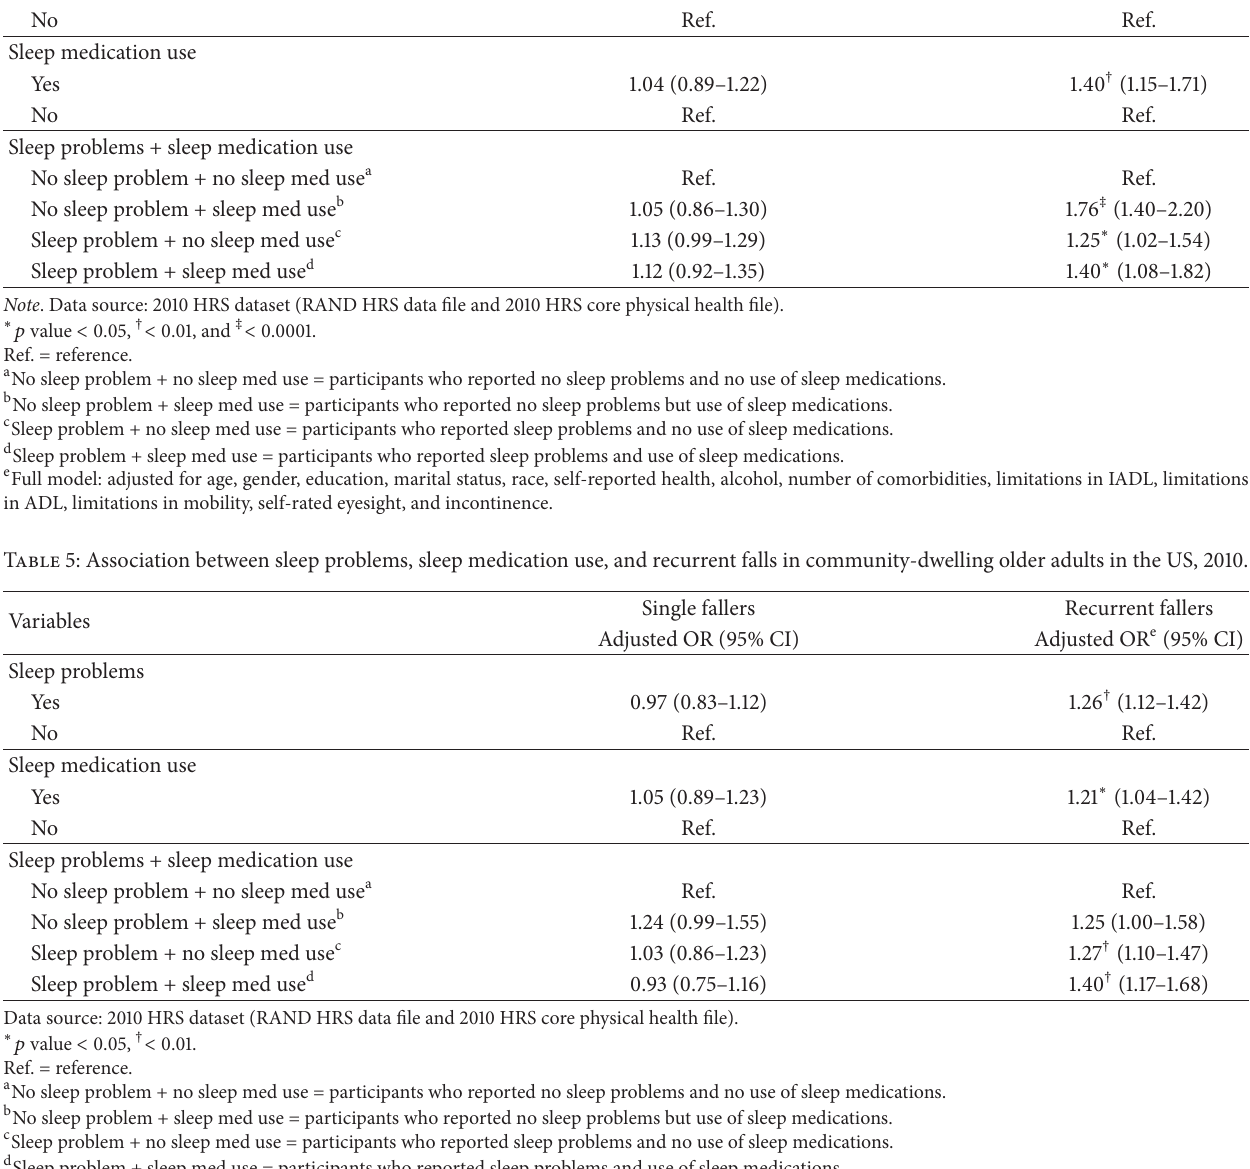
Table 4: Association between sleep problems, sleep medication use, and injurious falls in community-dwelling older adults in the US, 2010. Variables